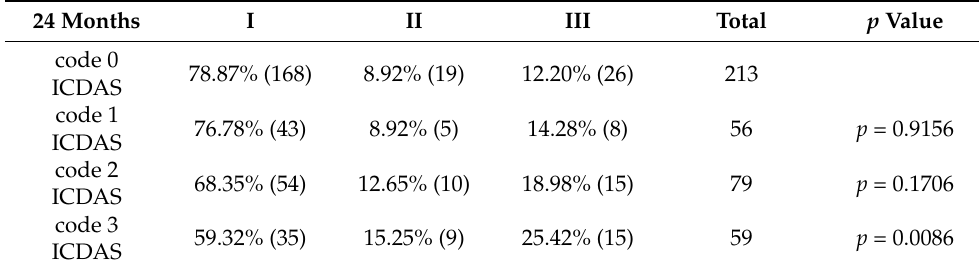
Table 5. Retention based on Simonsen’s criteria at the 24-month